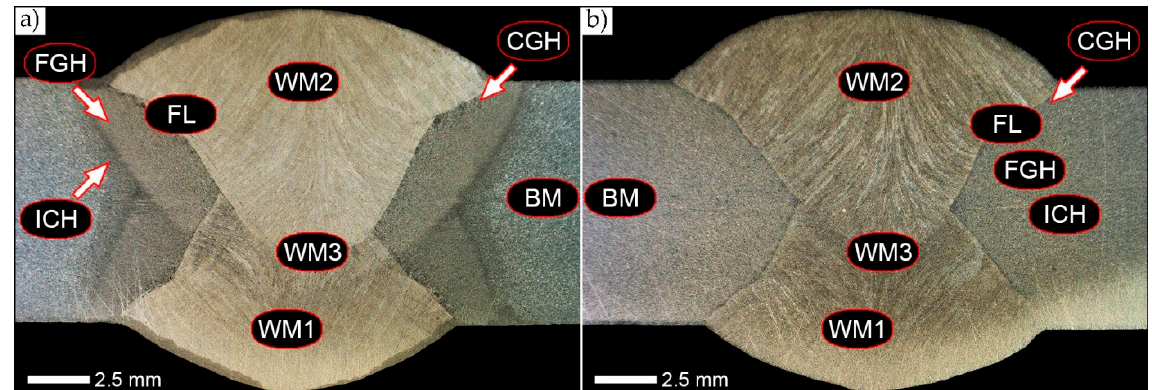
Figure 2. Macroscopic cross-sectional image of a welded joint of Hardox 450 steel: ( a ) delivery state (directly after welding), ( b ) normalised state. WM—weld metal zone, FL—fusion line, BM—parent metal zone, CGH(AZ)—coarse grain zone (overheating), FGH(AZ)—fine grain zone (normalisation and recrystallisation), ICH(AZ)—intercritical zone (incomplete normalisation), HAZ—heat-affected zone. Stereoscopic microscopy, etched with 3% HNO 3 and Adler’s reagent.